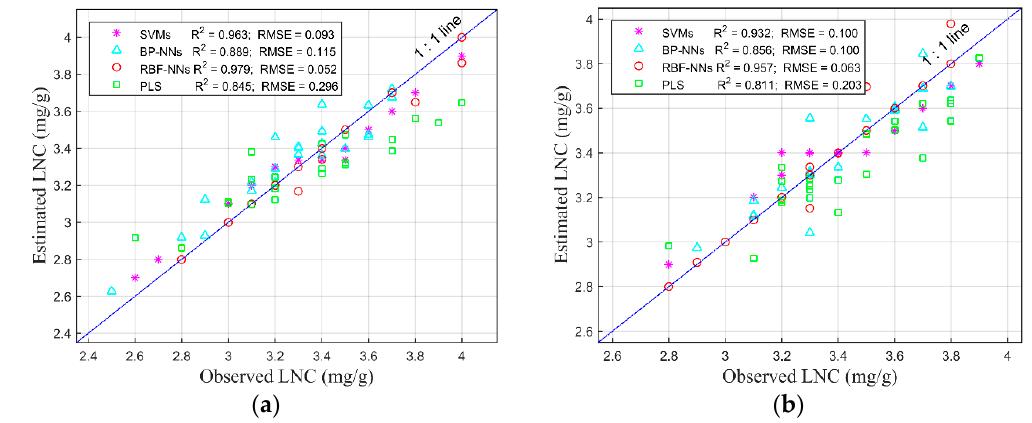
Figure 2. R 2 of estimation models and the 1:1 relationship between the observed LNC and those estimated using SVMs, ANNs (RBF-NN and BP-NN) and PLS in the ( a ) booting and ( b ) heading stages based on the reflectance spectra.